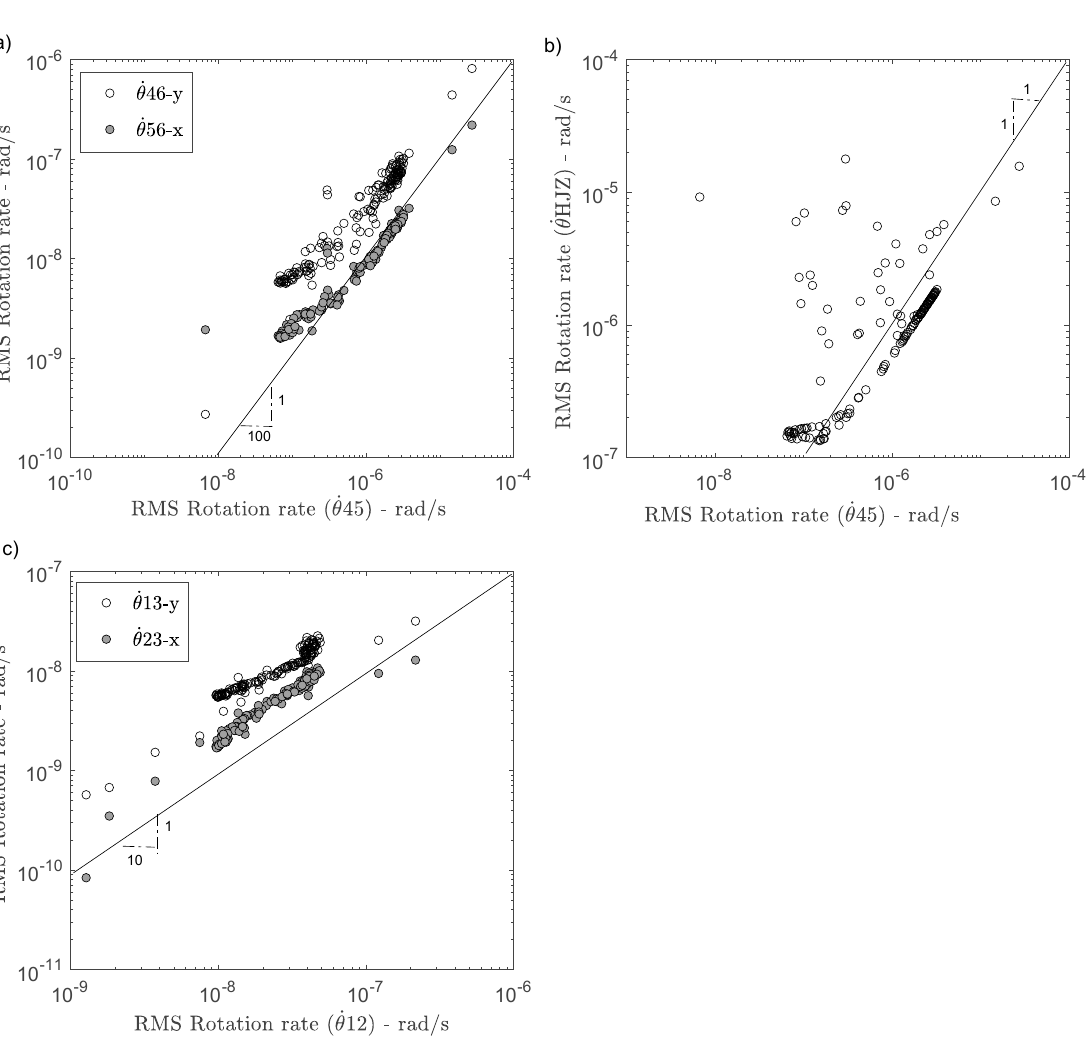
Figure 7. Comparison of the rotation rates calculated by the array-derived method at the top ( a ); with the rotation sensor HJZ ( b ) and at the bottom of the structure ( c ).